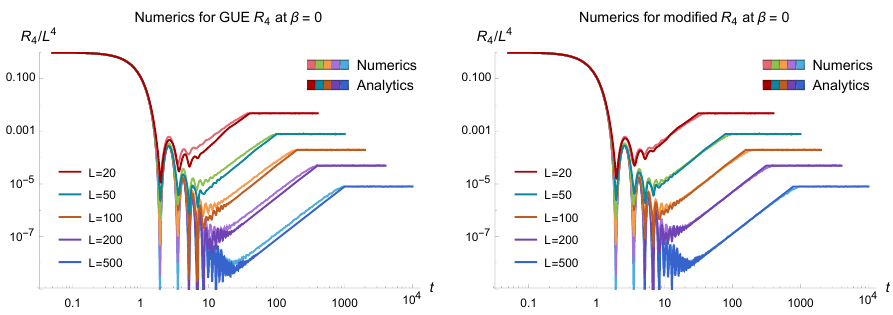
Figure 12 . Numerical checks the in(cid:12)nite temperature 4-point spectral form factor for GUE with 10000 samples, plotted for various values of L and normalized by their initial values. The left (cid:12)gure uses the R 4 expression derived in appendix C.1, and the right (cid:12)gure uses ~ r 2